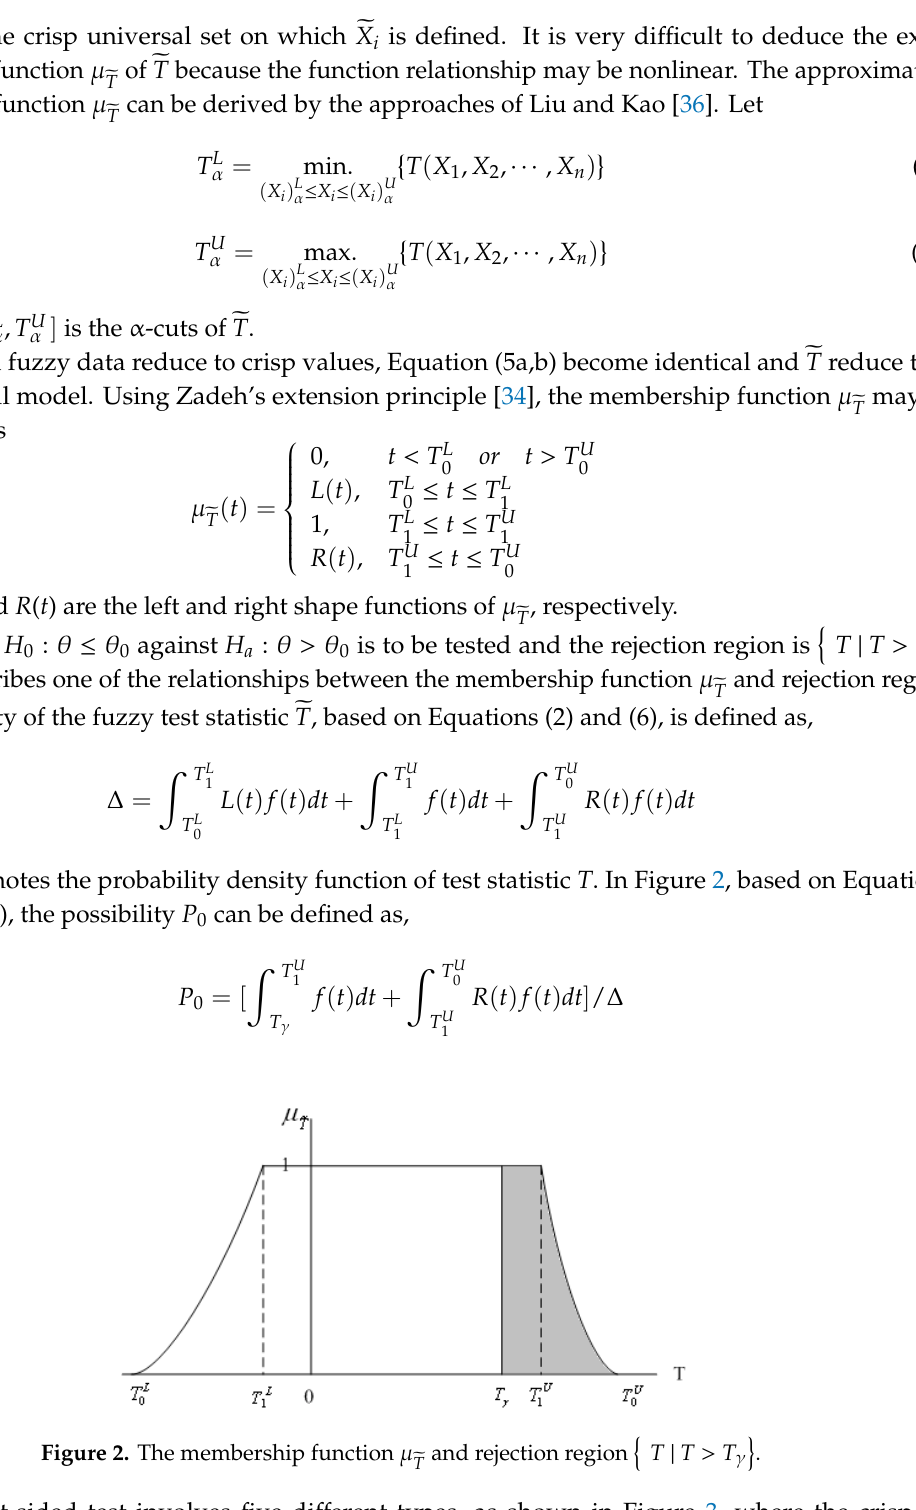
(cid:110) TTT  . Figure 2. The membership function µ T | T > T γ